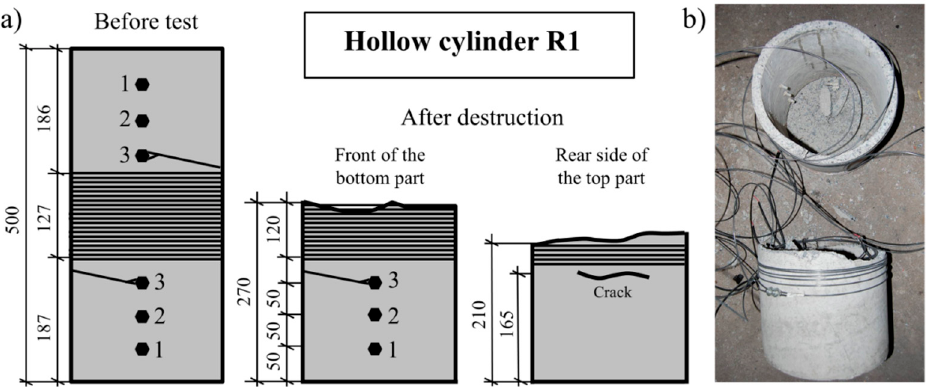
Figure 6 . R1 hollow cylinder before and after its destruction: ( a ) drawing of the specimen before destruction, with front of the bottom part and rear side of the bottom part after destruction; ( b ) photo of the R1 specimen after its destruction. Units in (mm) .